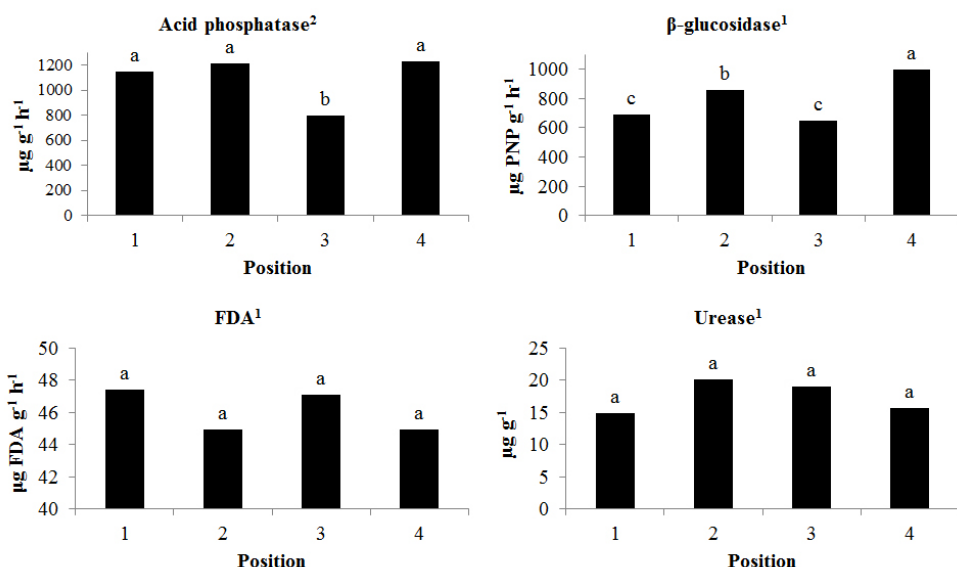
Figure 3 - Enzymatic activity in soil samples (0 to 20 cm) collected in different hillslope positions in the Bocaina Mountain Range, in Lavras – Minas Gerais, Brazil. 1 - upper backslope; 2 - middle backslope; 3 - lower backslope; 4 - footslope. Means followed by the same letter do not differ statistically, according to 1 Scott-Knott or 2 Kruskal-Wallis test (p